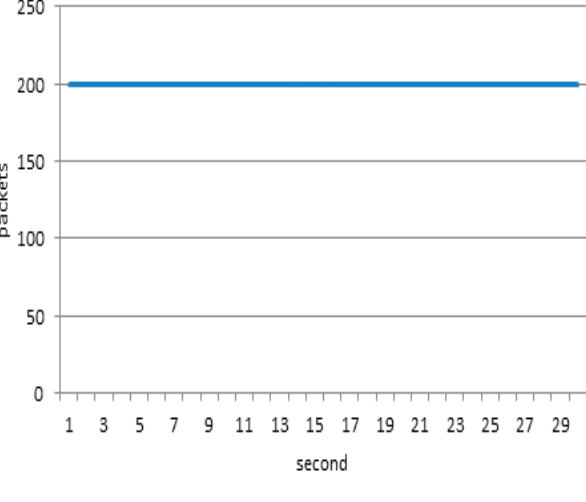
Figure 19. Flows of attack from Attacker 1.